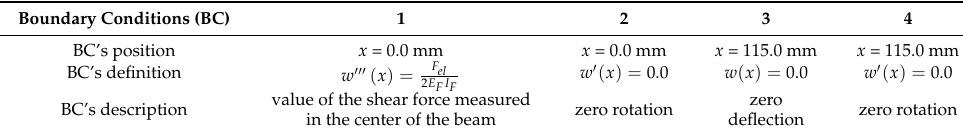
Table 2. The boundary conditions of the facing of the sandwich beam on the elastic foundation (core layer) subjected to the pull-out of the blind rivet test—analytical model. Boundary Conditions (BC) 1 2 BC’s position BC’s description value of the shear force measured in the center of the beam zero rotation zero deflection zero rotation